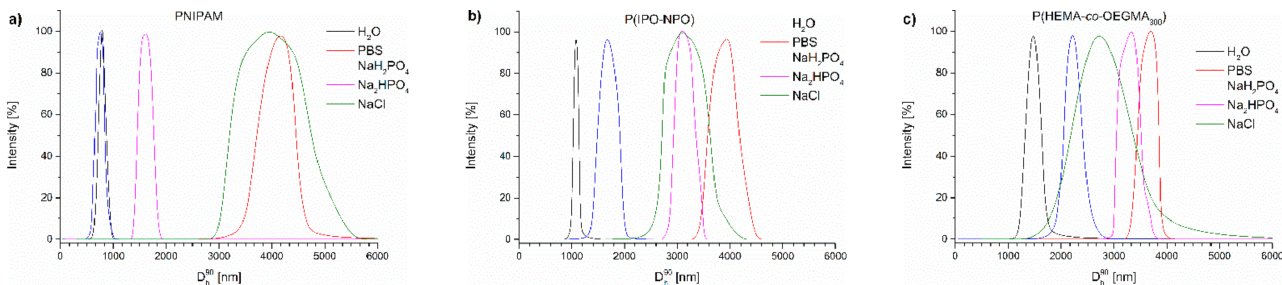
Figure 7. Size distribution of particles of ( a ) PNIPAM, ( b ) P(IPO- co -NPO) and ( c ) P(HEMA- co -OEGMA) acquired by slow heating in different salt solutions at 70 ◦